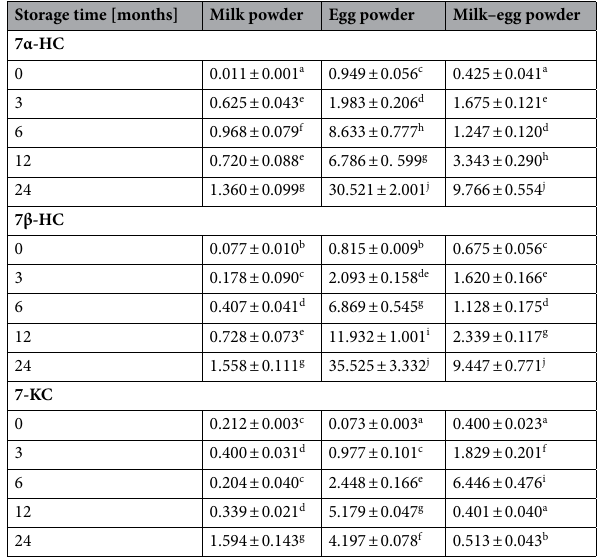
Table 4. Content (µg g −1 powder) of 7α-HC, 7β-HC, 7-KC in powders. a,b —different letters within the column denote statistically significant differences between the results (P < 0.05); ± means SD.